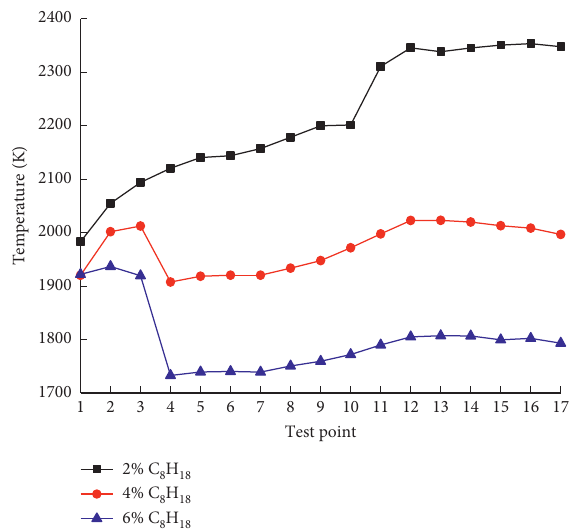
Figure 19: Curves of peak temperature under different gas concentrations.